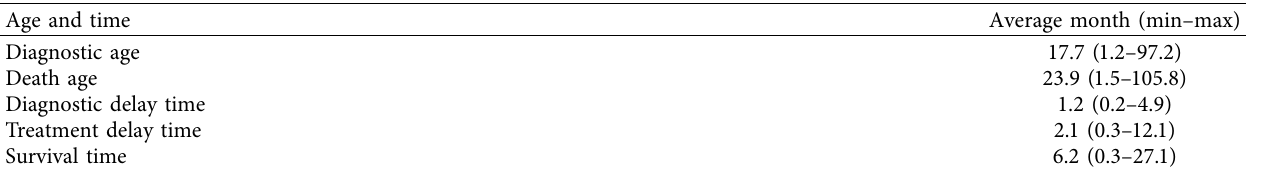
Table 4: Clinical average time information of 12 RB cause-specific mortality